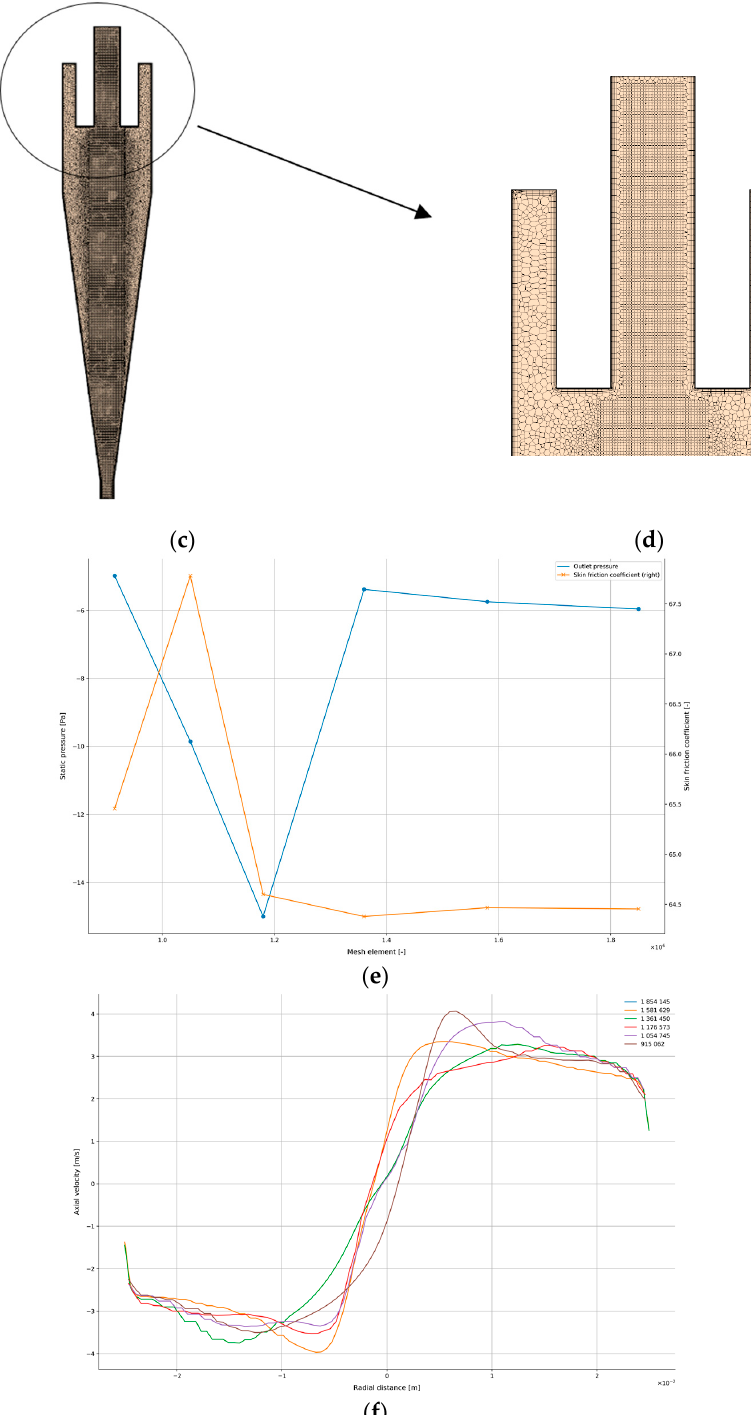
Figure 2. Polyhedral elements of the VF-20 mm model with ( a ) isometric and ( b ) top views, ( c ) plane view of the vortex finder diameter, ( d ) cut-away by the vortex finder length, mesh sensitivity study based on ( e ) outlet pressure at the overflow and wall skin friction coefficient; and ( f ) axial velocity profiles at radial distance within the entrance to the vortex finder, respectively.